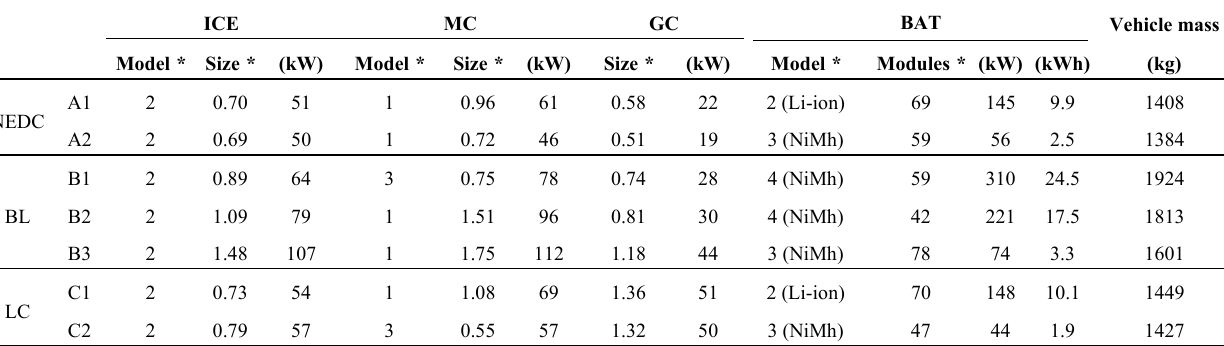
* model and size as in Table